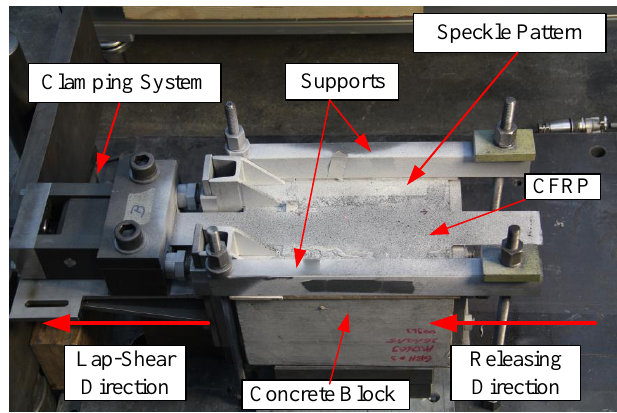
Figure 7. Lap-shear testing setup including the speckle pattern applied on the top surface of strengthened